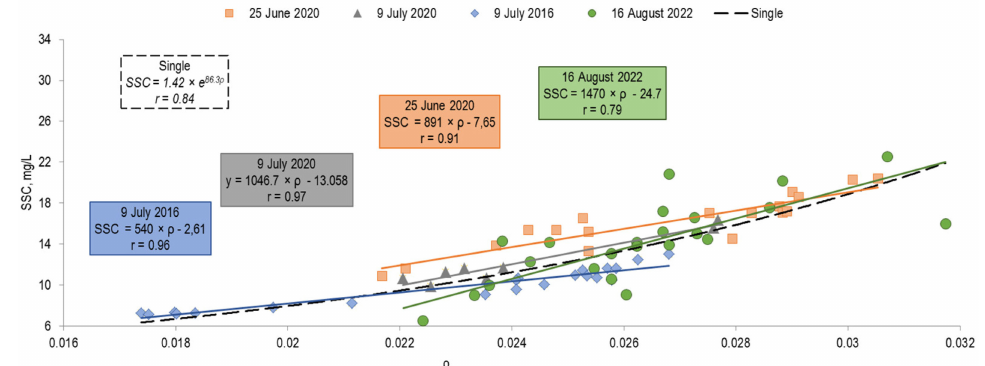
Figure 5. A regression model derived for the Lena River. SSC —suspended sediment concentration of water, ρ —the reflectance coefficient of the Landsat 8 images in the red band. The lines show the regression equation lines from Table 3.